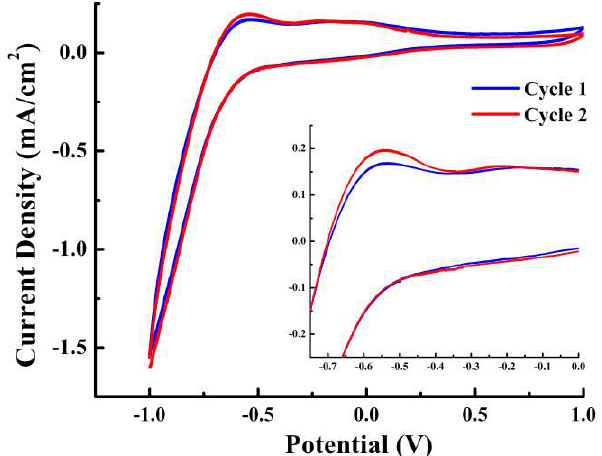
Figure 1. Cyclic voltammetry data of etched Ti substrate with a scan rate of 100 mV/s. Inset is the enlarged curve ranging from − 0.75 to 0 V. A significant peak was observed at approximately − 0.55 V.